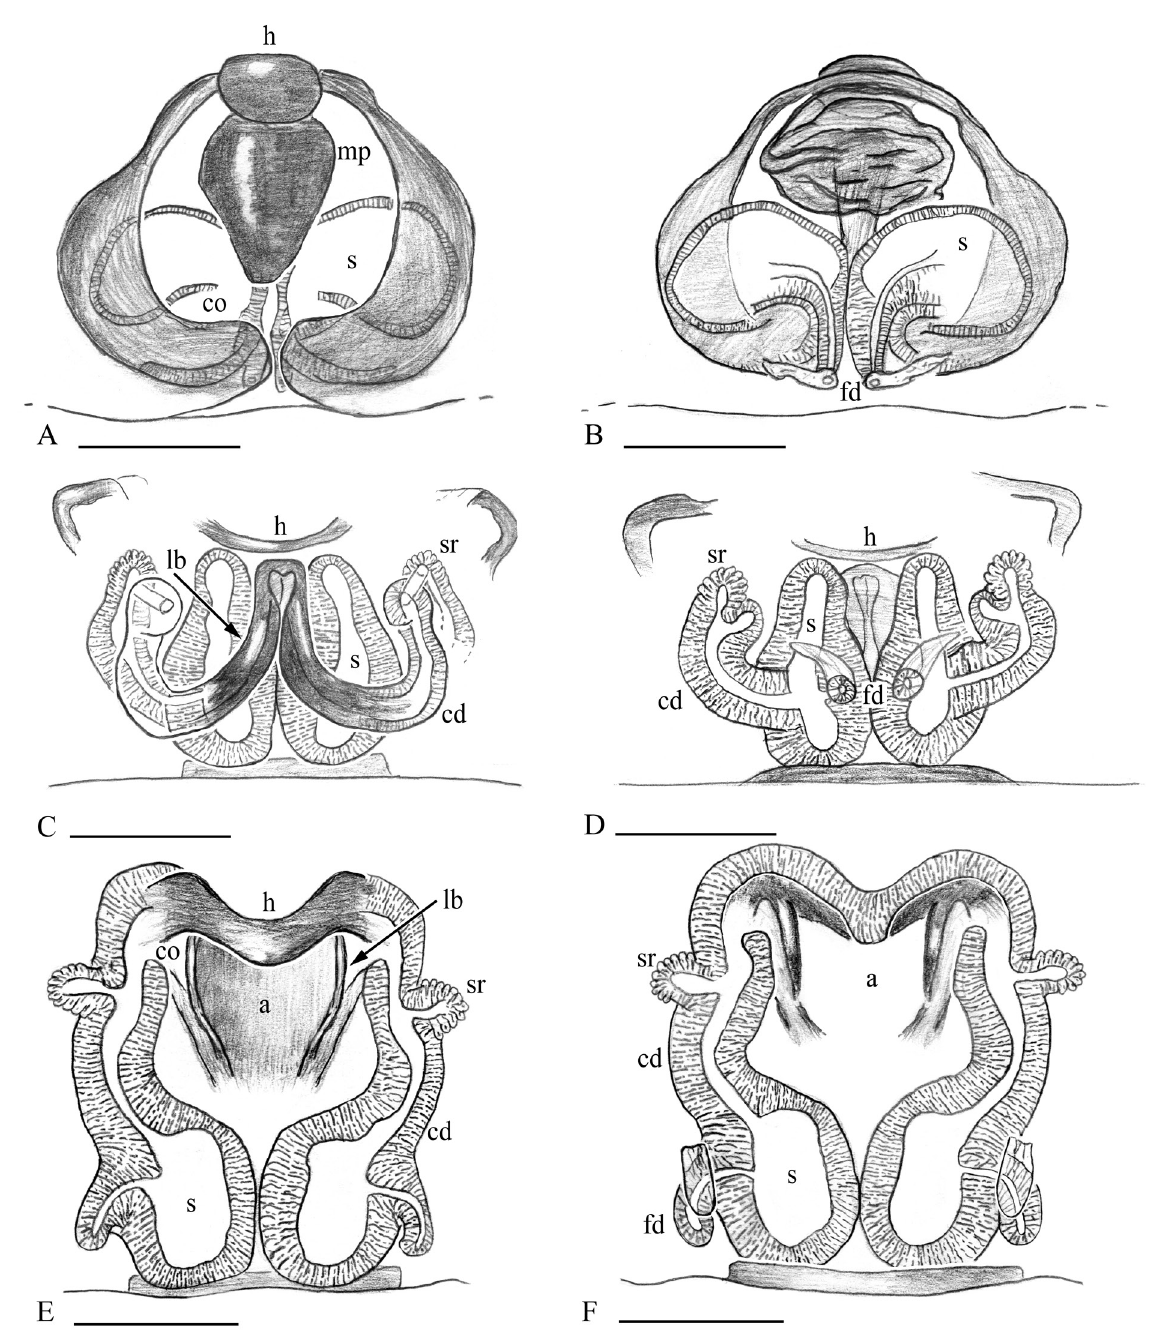
Fig. 18. Anyphaena spp. A–B . A. fernandae sp. nov., holotype, ♀ (CNAN-T01526). A .